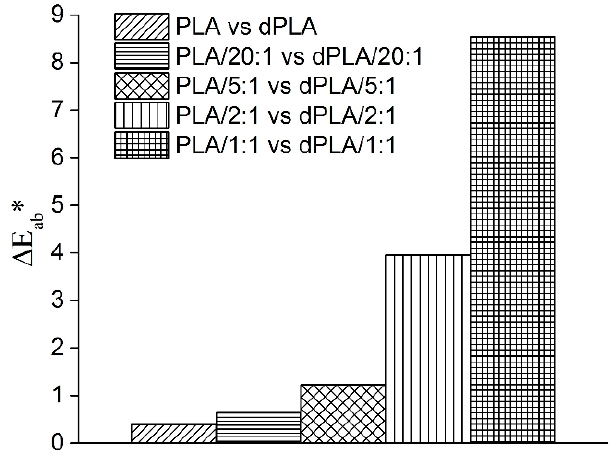
Figure 4. Values of ∆ E ab * parameter for tested films.